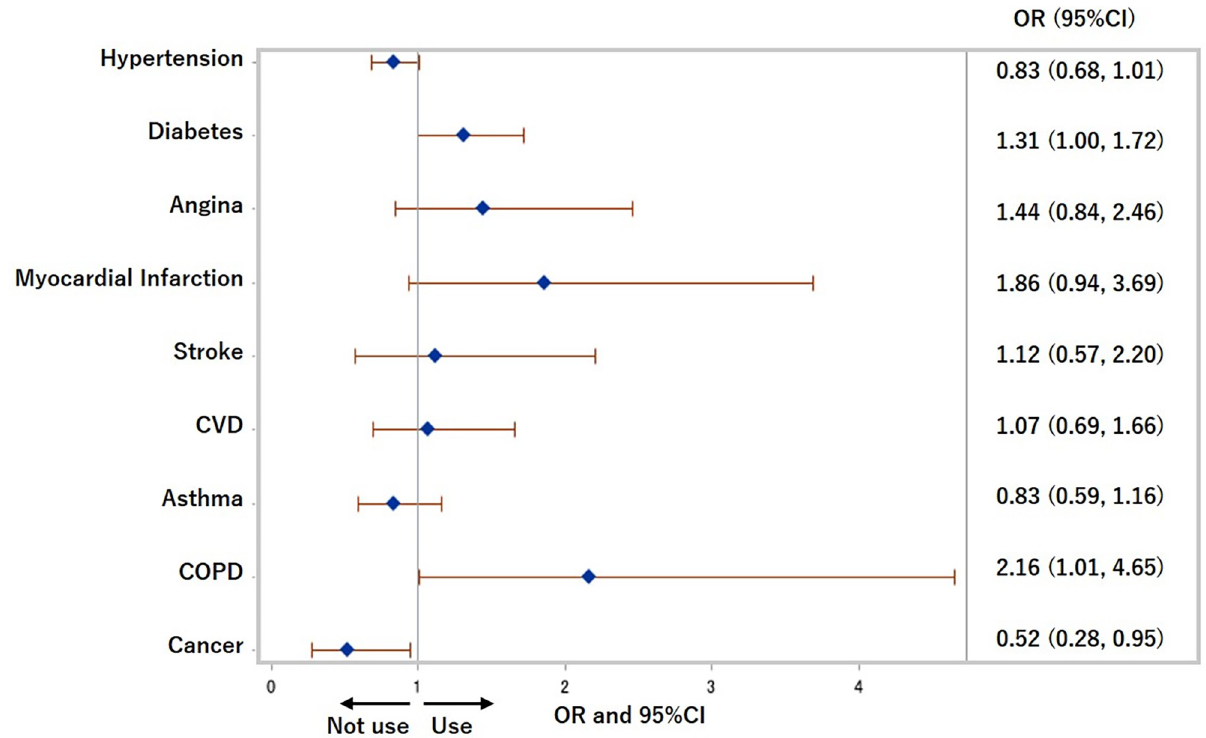
Fig 3. Odds ratios for use of cigarettes in previous 30 days. COPD: Chronic obstructive pulmonary disease, CVD: Cardiovascular disease, OR: Odds ratio. Adjusted for age, sex, heated tobacco products use, equivalent household income, education, and drinking status.